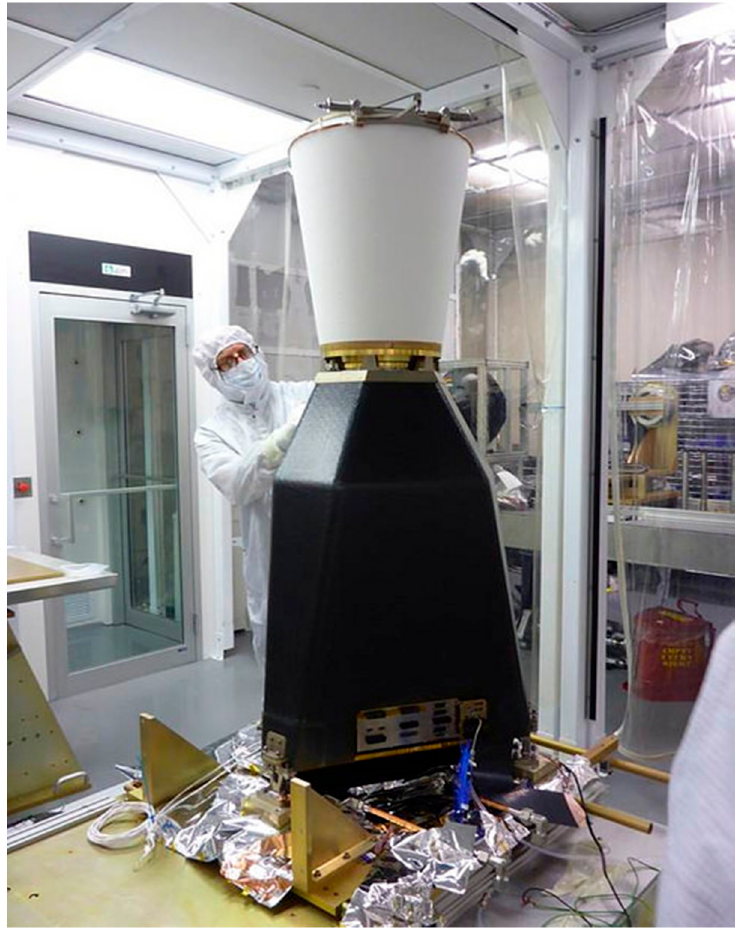
Figure 1. GLM assembly with sun shade pre-launch [23].